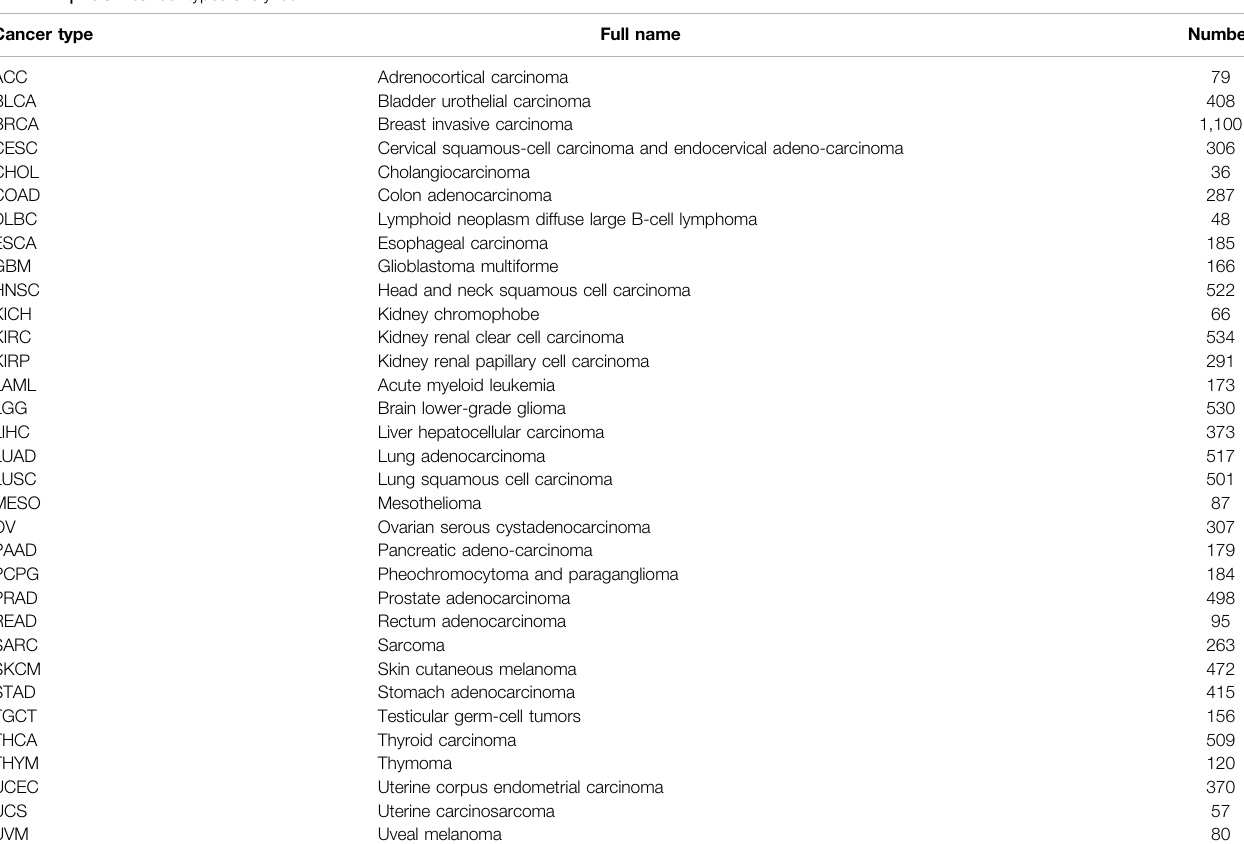
TABLE 1 | TCGA cancer types